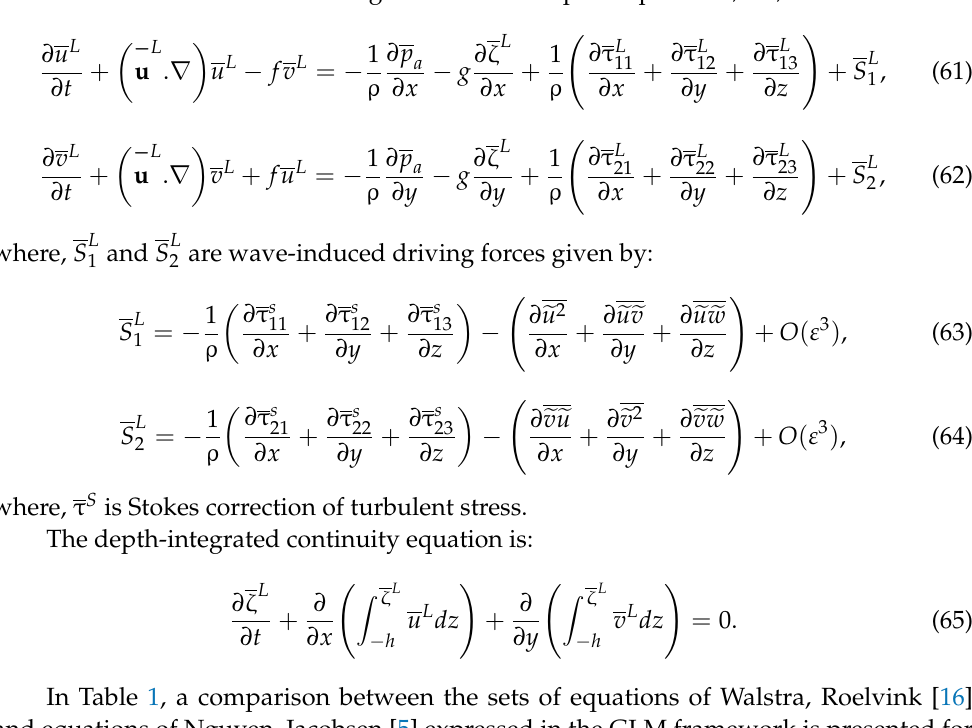
Table 1. Comparison between Walstra, Roelvink [16] and Nguyen, Jacobsen [5]. Terms Walstra, Roelvink [16] Nguyen, Jacobsen [5] Pressure gradient Conservative wave forcing Non-conservative wave forcing F br ,1 ρ : applied as a surface stress F fr ,1 ρ : applied as a bottom stress Turbulence Mass